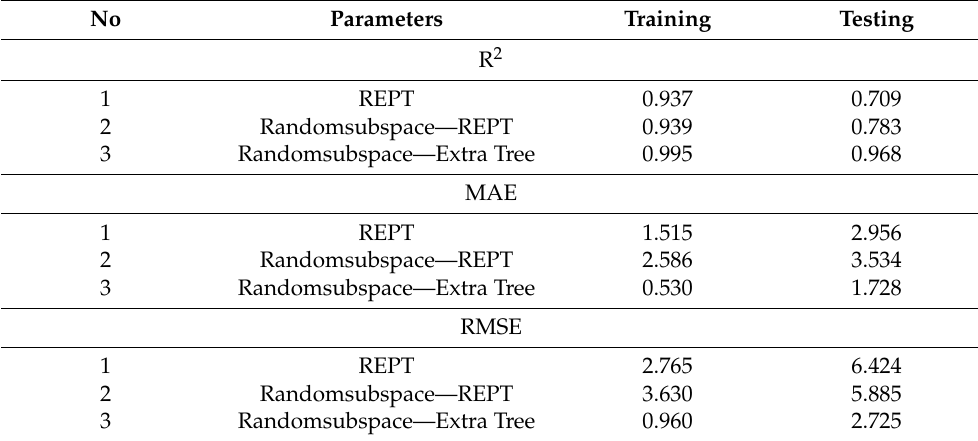
Table 3. Statistical analysis results stemming from the current study.